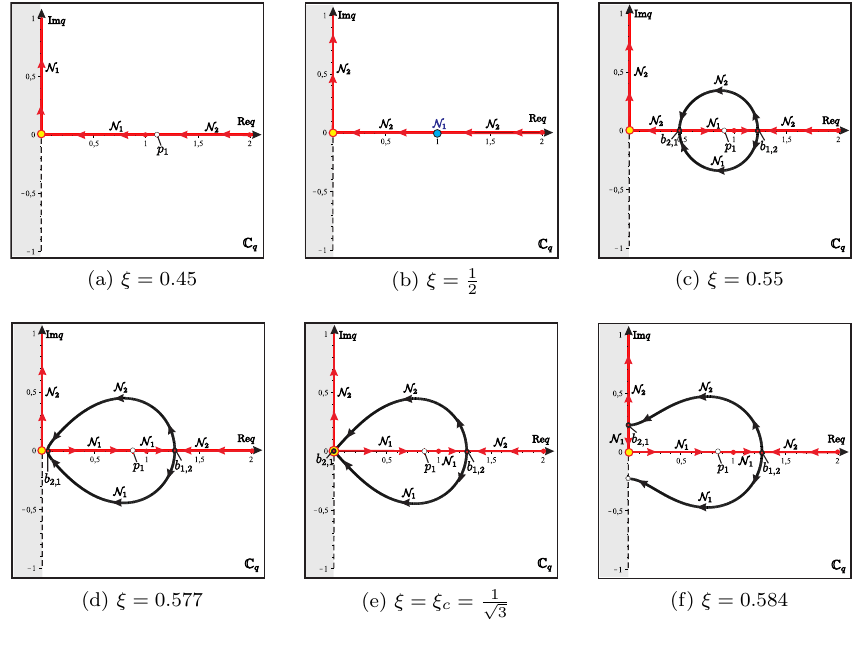
Figure 8. Spectrum Curves for various parameter ξ values. – Critical Point at Branch Eigenvalue